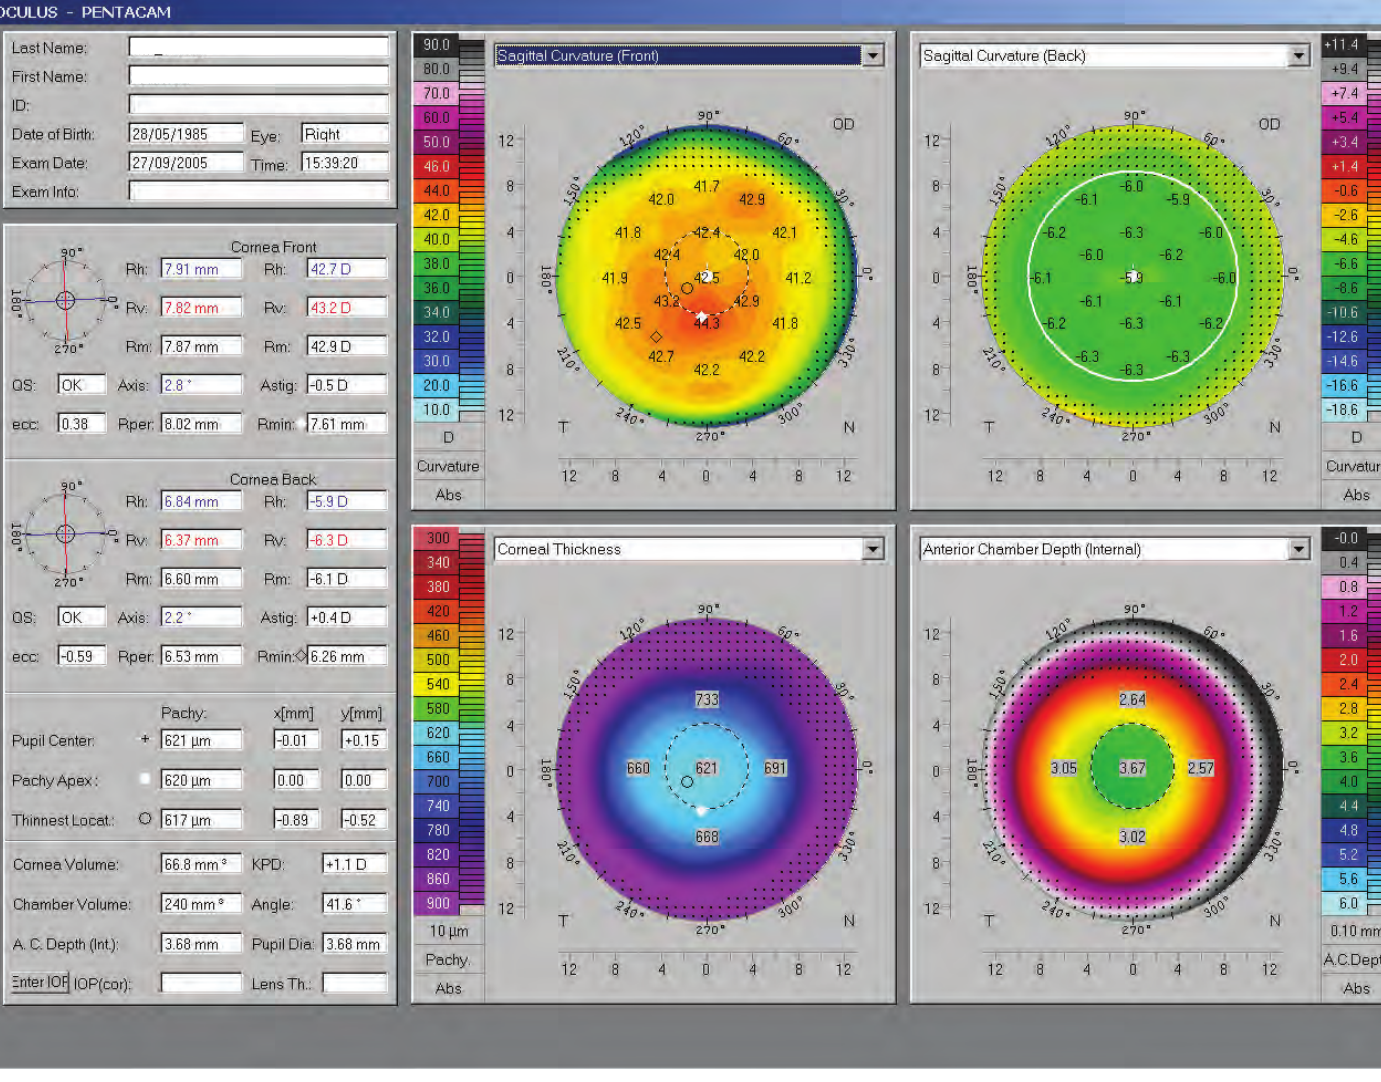
Figure 1 . The first Pentacam result or measurement of the cornea and anterior segment of the right eye of Subject 1 are indicated. The anterior (the top left map) and posterior (the top right map) corneal surfaces are represented using sagittal curvature maps. Maps for corneal thickness and anterior chamber depth are also shown. Other quantitative data for the cornea and anterior segment of this subject are provided in the column towards the left side of the